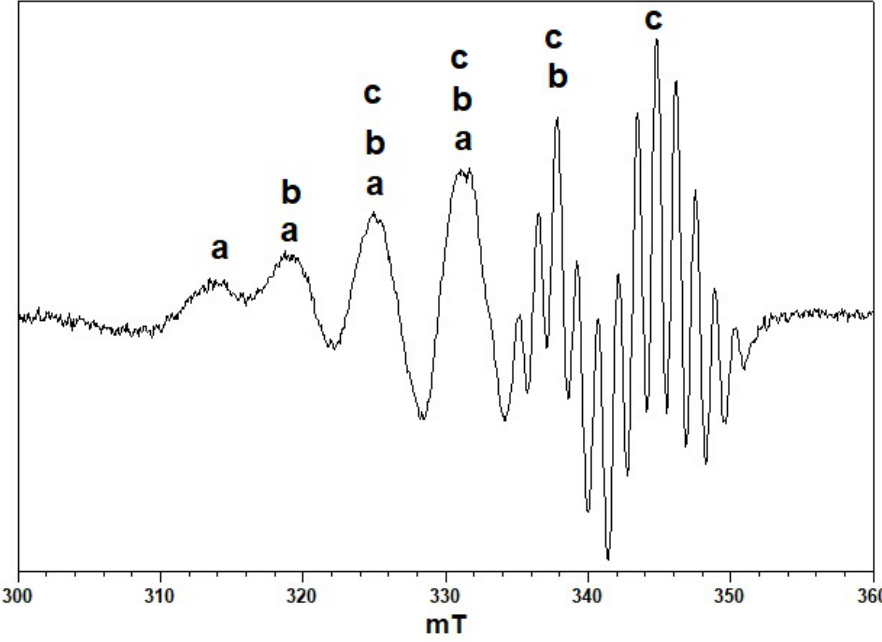
Figure 7. RT EPR 2nd derivative spectrum in an aqueous solution of Cu-Sar-LH at pH 5.1. Three